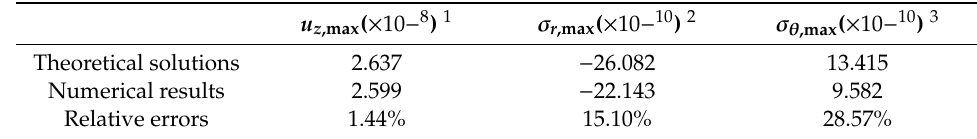
Table 3. The maximum values and relative